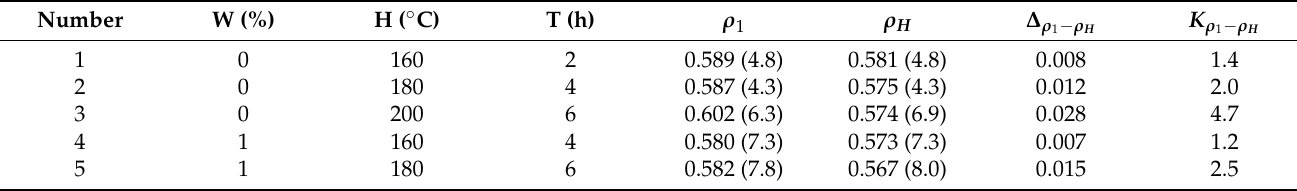
Table 4. Analysis of total dry density range of impregnated heat-treated